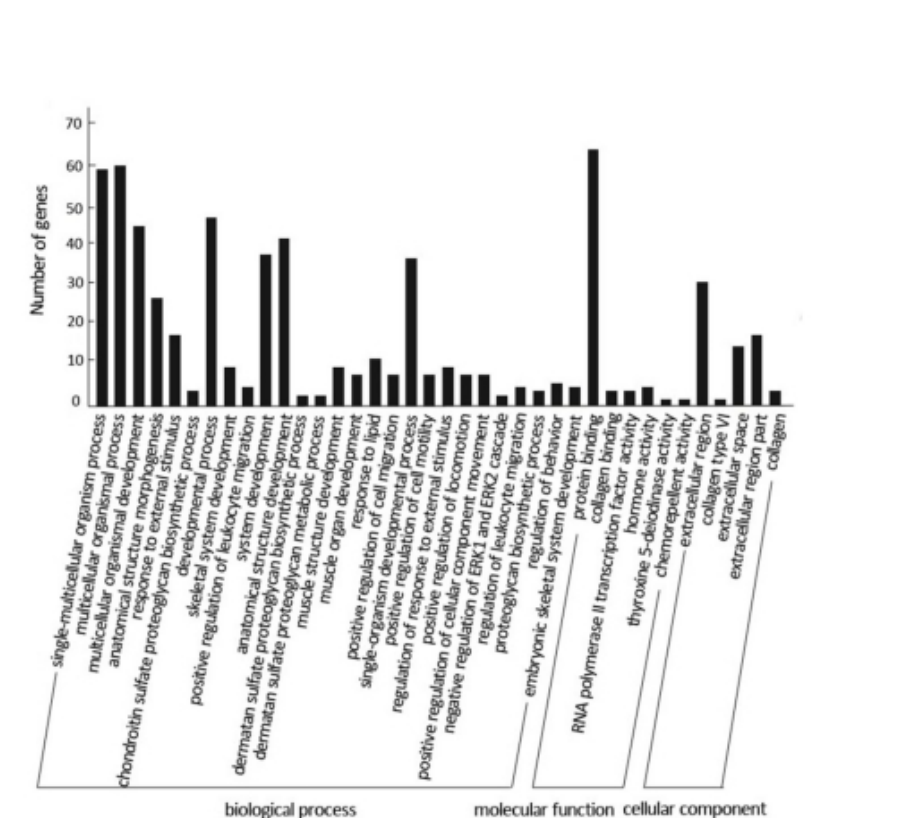
Ontology (GO) functional annotation. The left- hand Y axis represents the number of genes in the